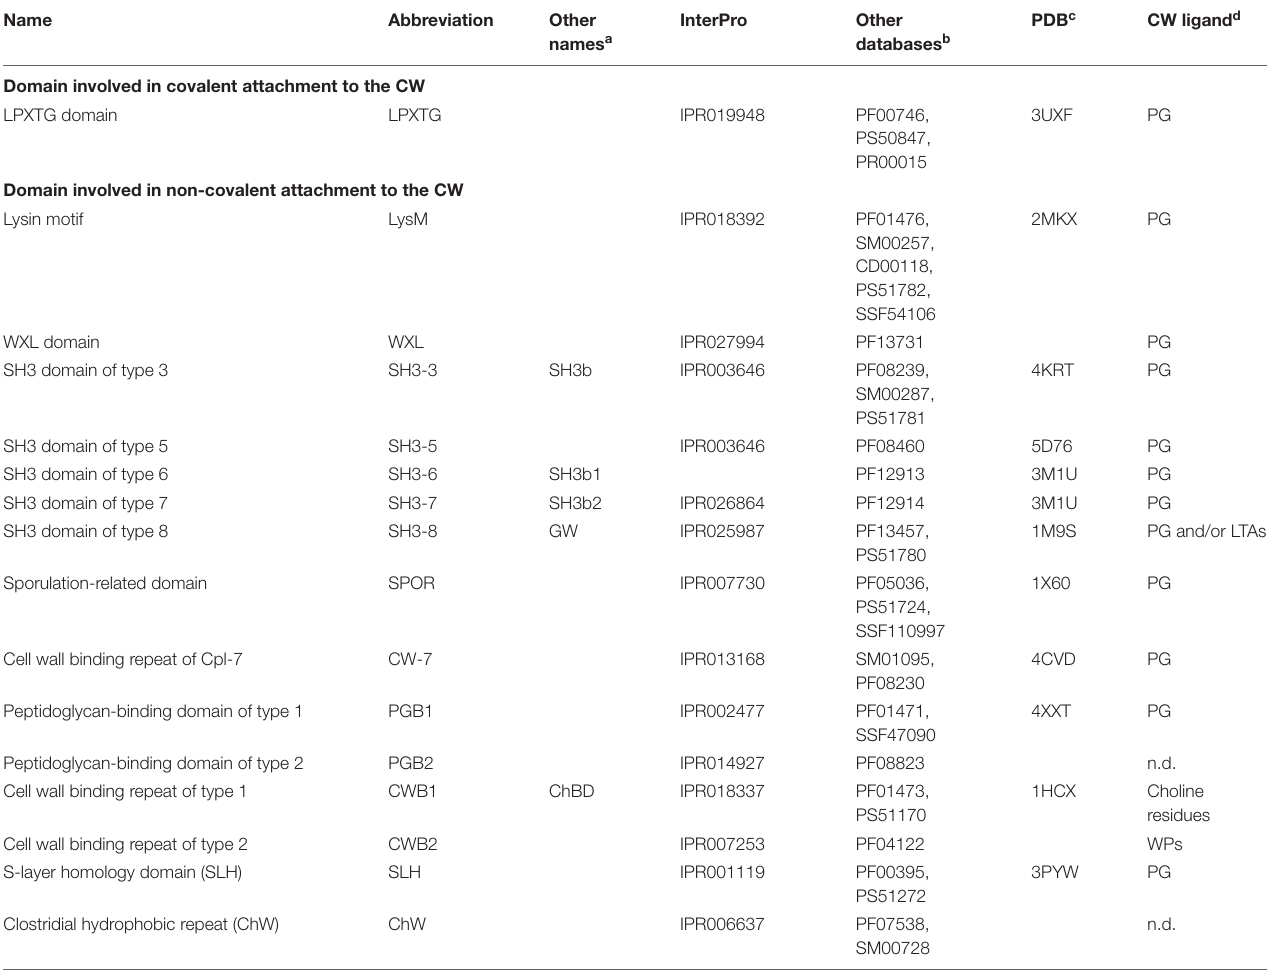
TABLE 1 | Domains involved in protein attachment to the cell wall in parietal monoderm